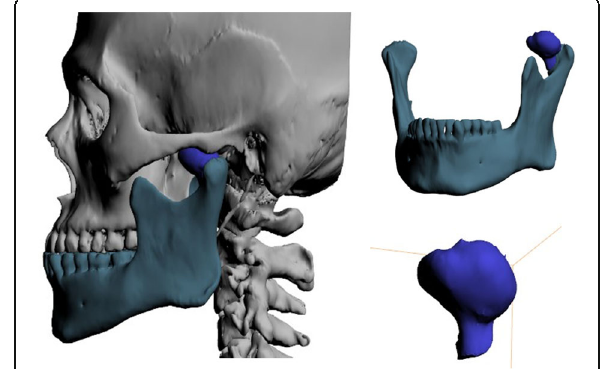
Fig. 4 Reconstruction of three-dimensional image was